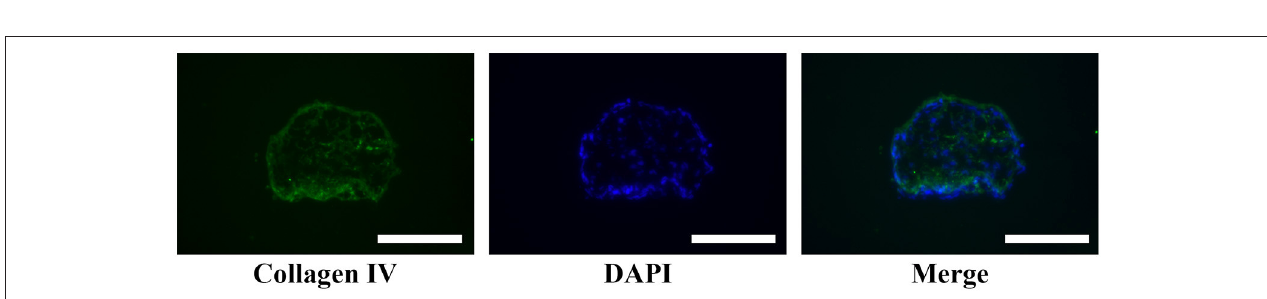
FIGURE 2 | Phase contrast microscopy showing the aggregation process of 10,000 hADSCs into microtissues (MTs) and the post-adhesion MTs on a Petri dish. (A) hADSCs cultured on a Petri dish (passage 4); (B) morphology of MTs on day 3. The appearance of MTs became stable with a smooth edge on day 3; (C) MTs on day 3 seeded onto a Petri dish for 6h for adhesion; cells were seen around the adherent MTs. Inset bar = 200 µ m.